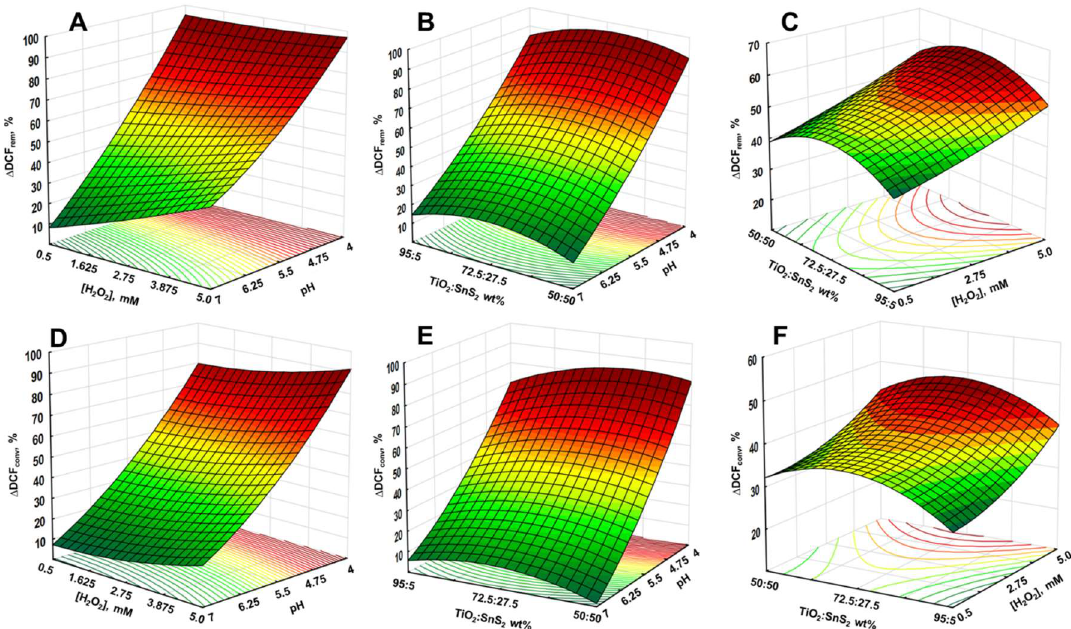
Figure 10. 3D response surface and contour diagrams showing the effects of the mutual interactions of initial pH and H 2 O 2 ( A , D ), pH and SnS 2 wt % ( B , E ), and H 2 O 2 and SnS 2 wt % ( C , F ) on the DCF removal (top row) and conversion (bottom row) by solar/TiO 2 -SnS 2 -HT/H 2 O 2 process (SnS 2 wt %, H 2 O 2 and pH were held at their respective center levels in ( A , D ), ( B , E ) and ( C ,F), respectively).